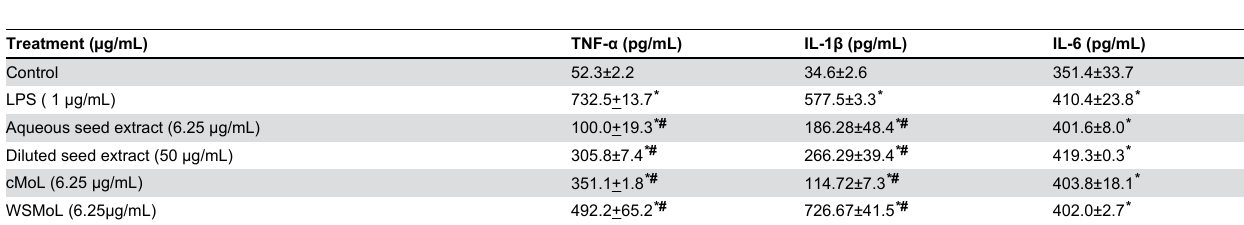
Table 3. Effect of M. oleifera seed extracts and lectins (cMoL and WSMoL) on TNF-α, IL-1β and IL-6 production by murine macrophages stimulated with LPS.